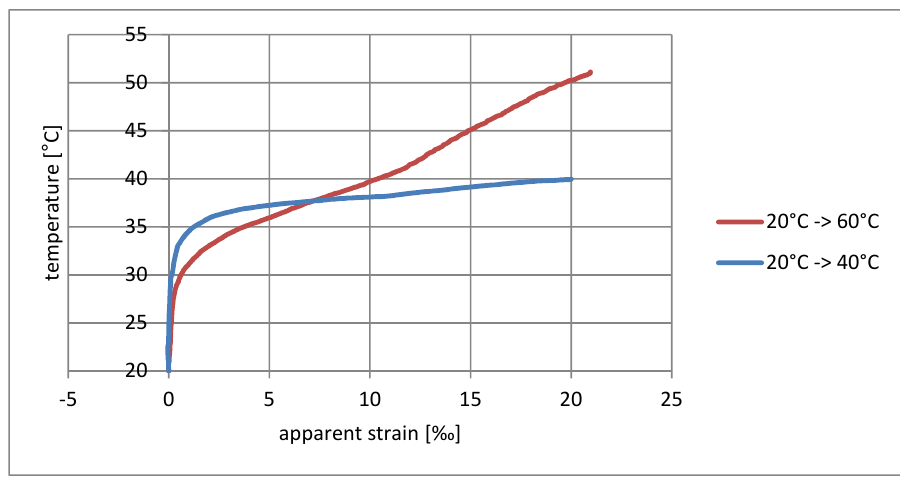
Figure 5. Dependence of apparent strain on decreasing temperature for the wooden sample.